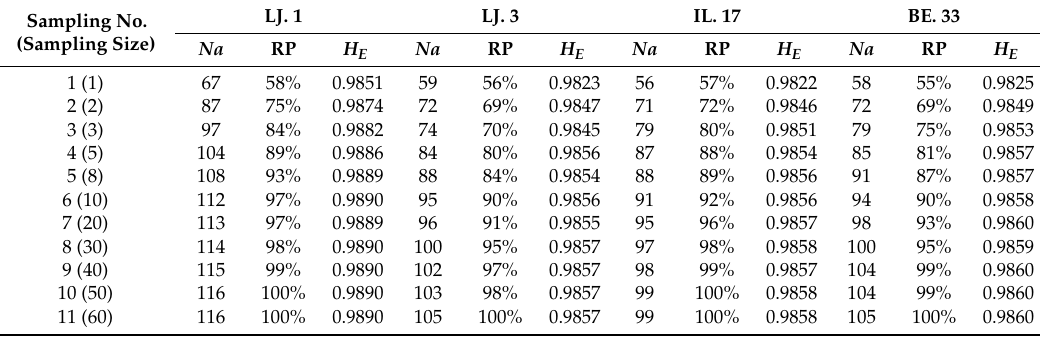
Table 3. The Fixation index values (FST) and the Shannon information index of the four accessions.